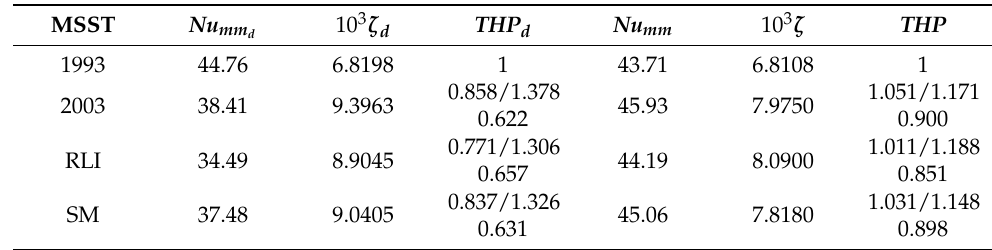
Table 2. Thermal and thermal-hydraulic performances of the control area and the hydraulic losses for the standard and modified SST models.